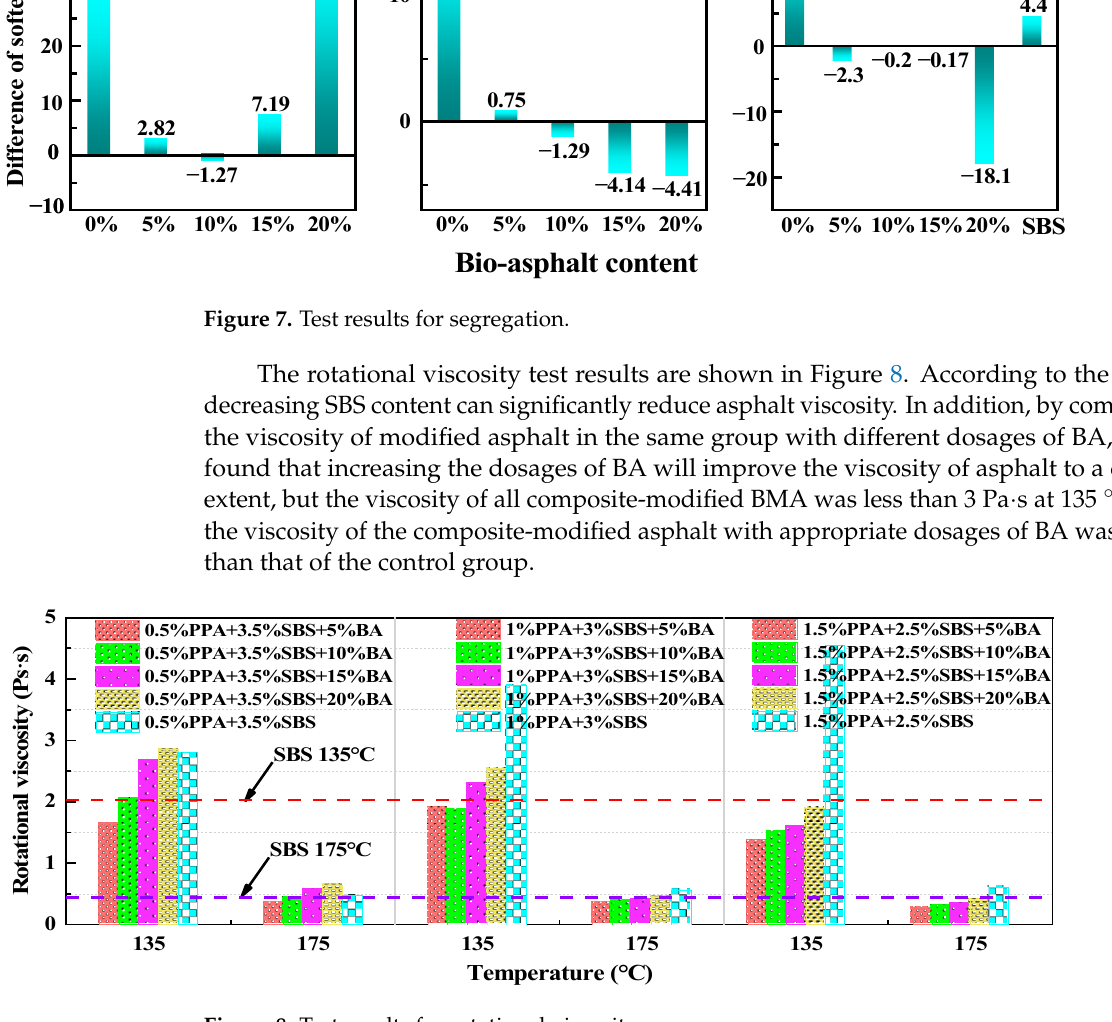
Figure 6. Test results for elastic recovery.